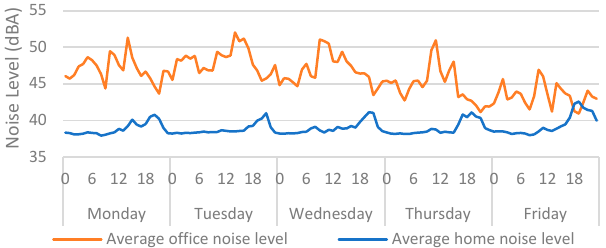
Figure 6. Average home/office noise levels categorised by day > hour for Monday to Friday. Quali- tative findings are displayed alongside the quantitative data for context.